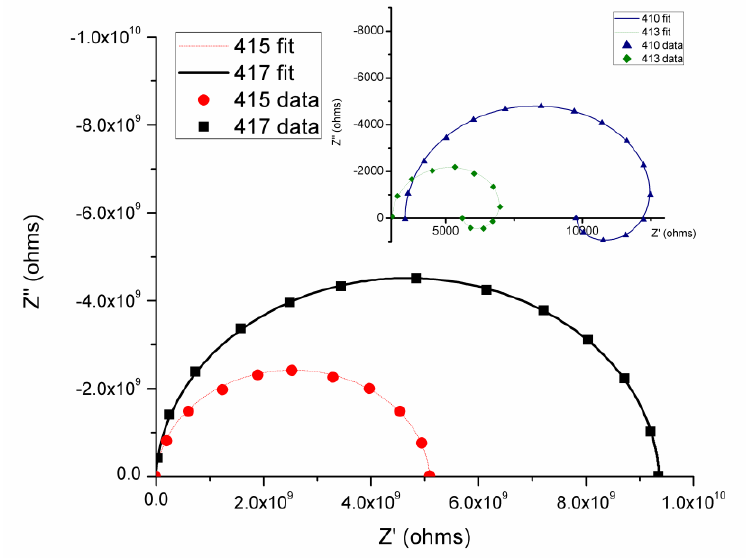
Figure 10. Nyquist plots for frequency response of multi-walled carbon nanotubes deposited on 410 and 413 (inset), and 415 and 417 filter papers [61]. Used with permission from Springer Nature.